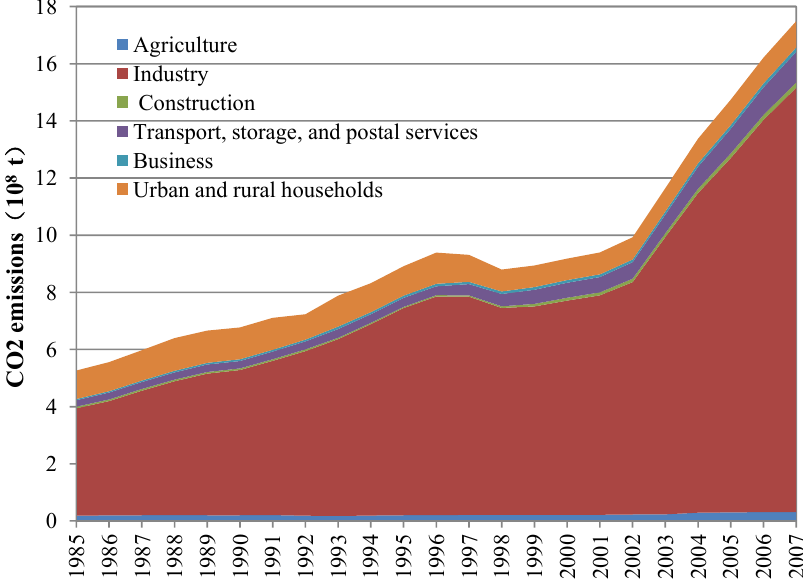
emissions in six different sectors. 2